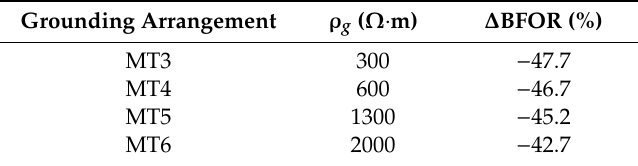
Countermeasure 2: improvement of the lightning performance for di ff erent soil resistivity values.